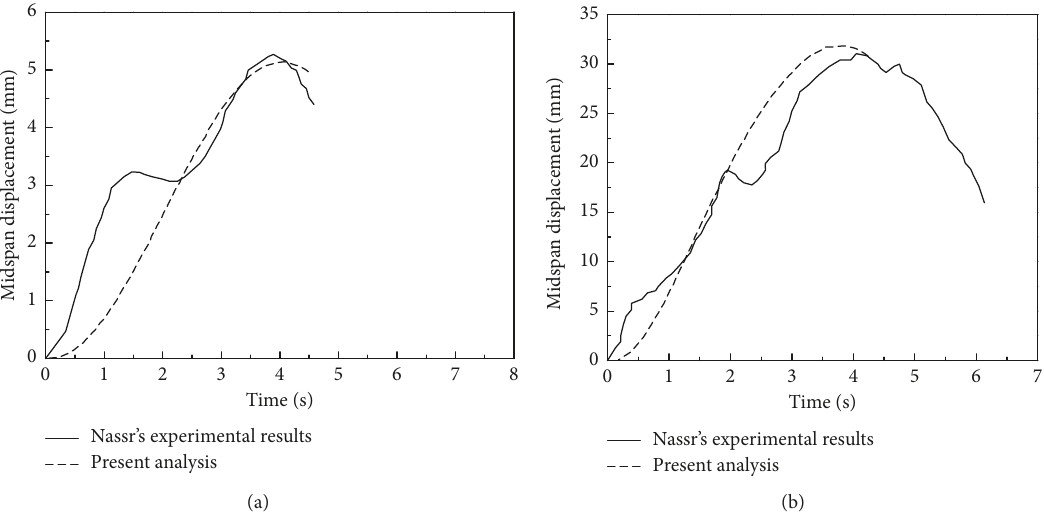
Figure 11: Experimental midspan displacements plotted against those predicted by SDOF analysis. (a) Comparison of the midspan displacements for shot 1. (b) Comparison of the midspan displacements for shot